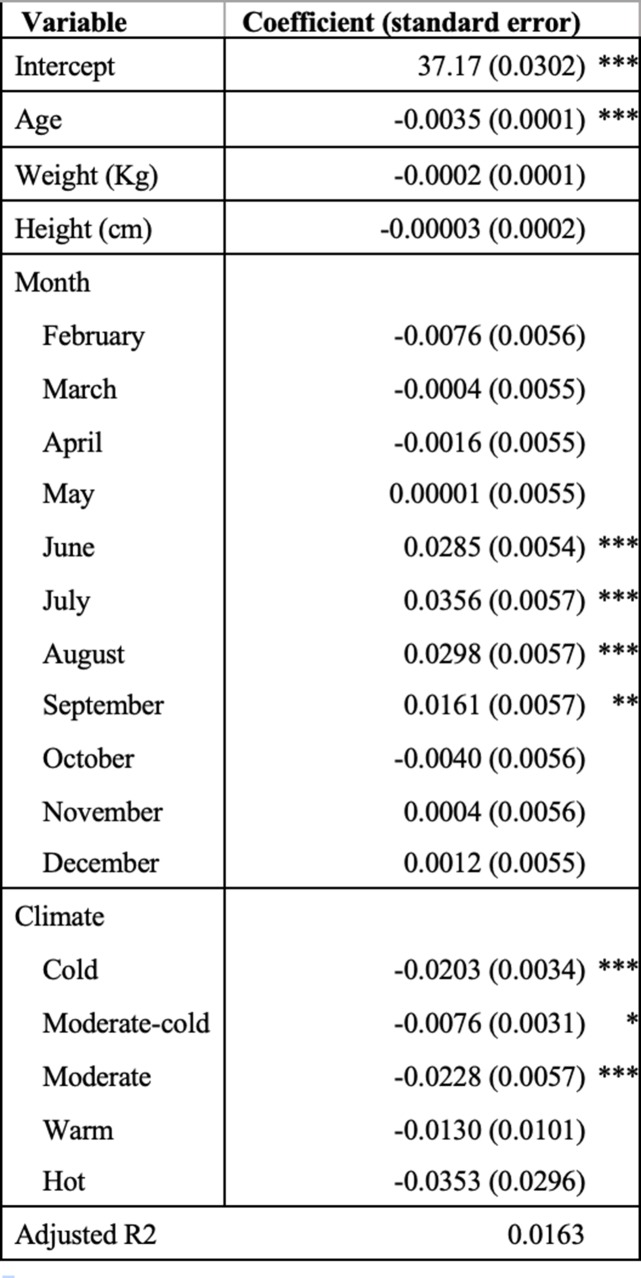
Analysis using both month and location.Coefficients (and standard errors) are from a multivariate linear regression model for the UAVCW cohort including age, weight, height, month and state climate classification (cold, moderate-cold, moderate, warm or hot). While UAVCW provided state information, NHANES I provided general region only and STRIDE was in Northern California only. *, **, *** indicates significance at the 90%, 95%, and 99% level, respectively.Figure 1—figure supplement 6—source code 1.R code for Figure 1—figure supplement 6.